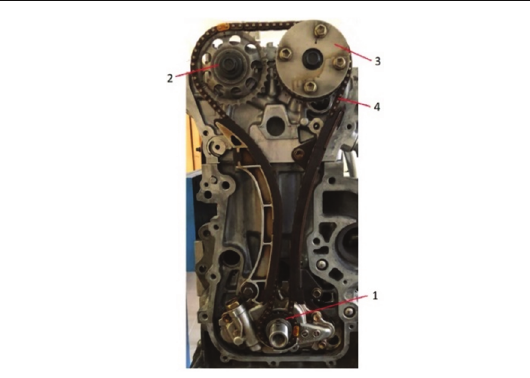
Fig. 2. The chain transmission